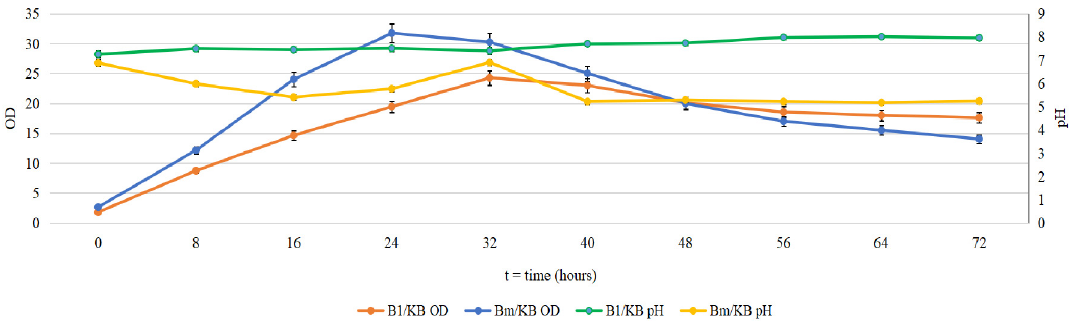
Figure 2. Growth of P. putida (B1) and B. mycoides (Bm) strains in King B (KB) medium.